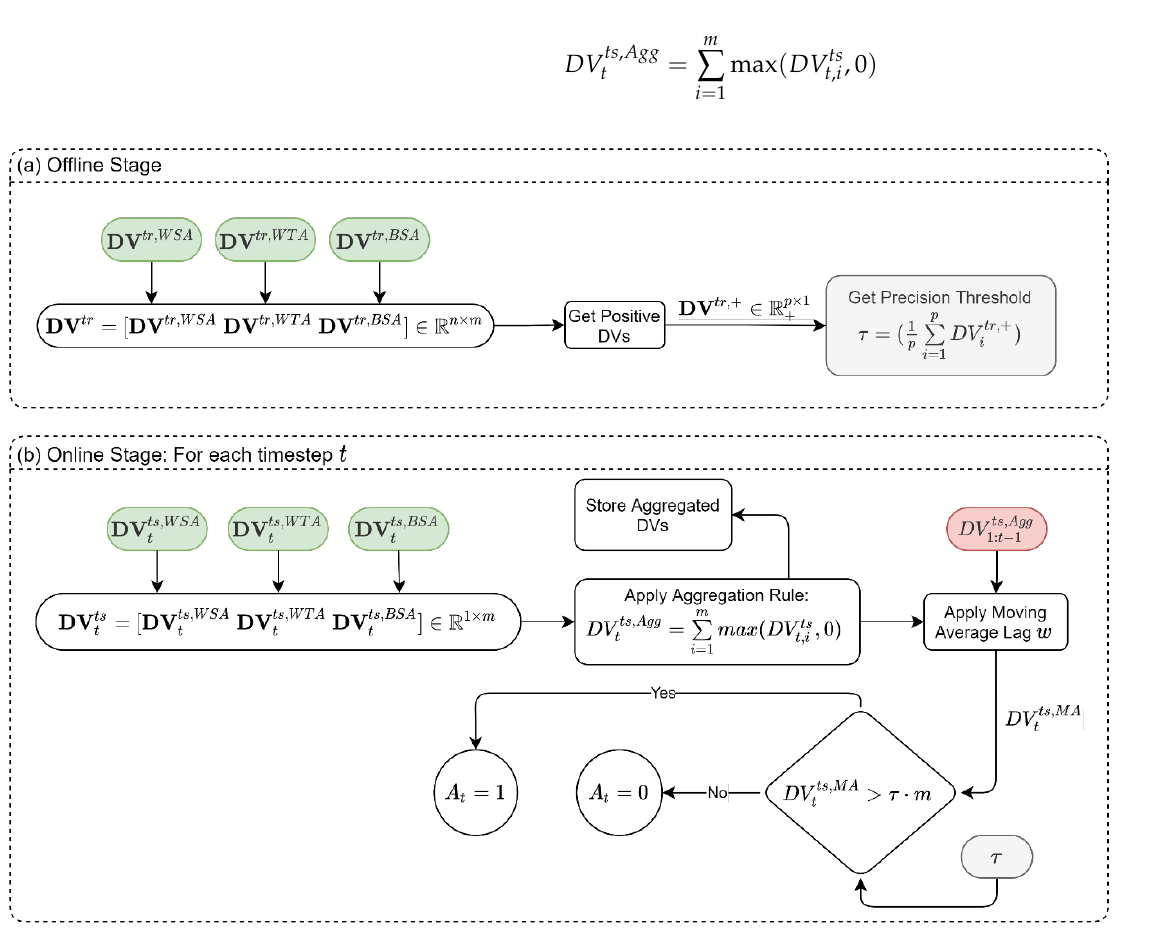
Figure 5. SSDS synthesis and detection process: ( a ) Offline Stage, ( b ) Online Stage. Notes: Gray shade is the data created in the offline stage and used in the online stage; Red shade is the data saved in previous timesteps; Green shade is the data used in the synthesis module from previous modules.